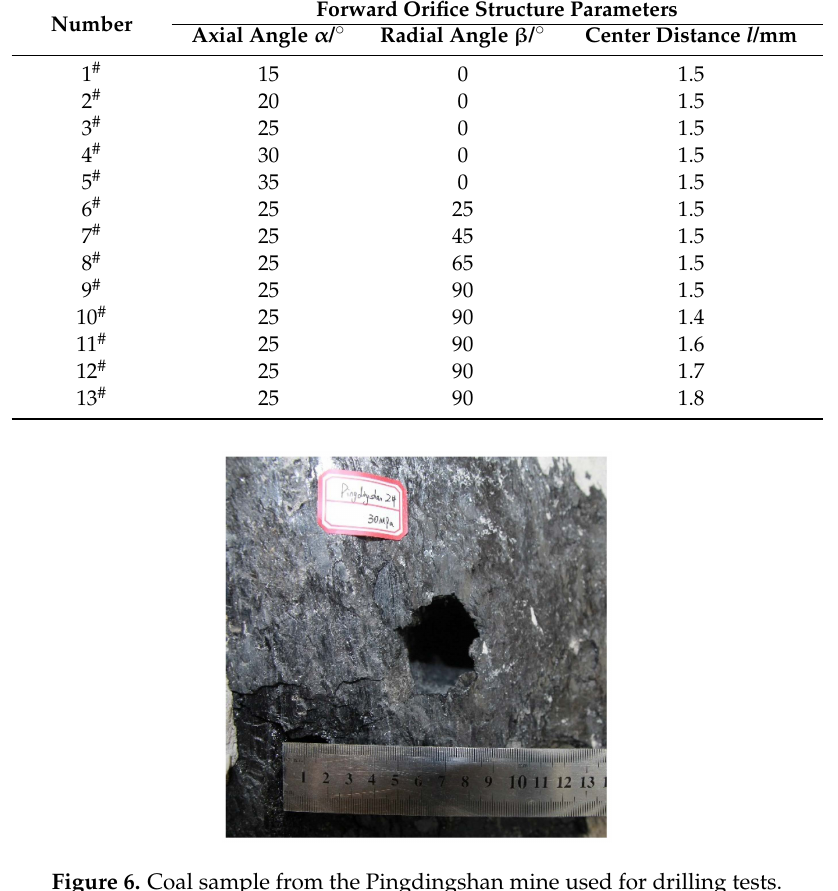
Figure 6. Coal sample from the Pingdingshan mine used for drilling